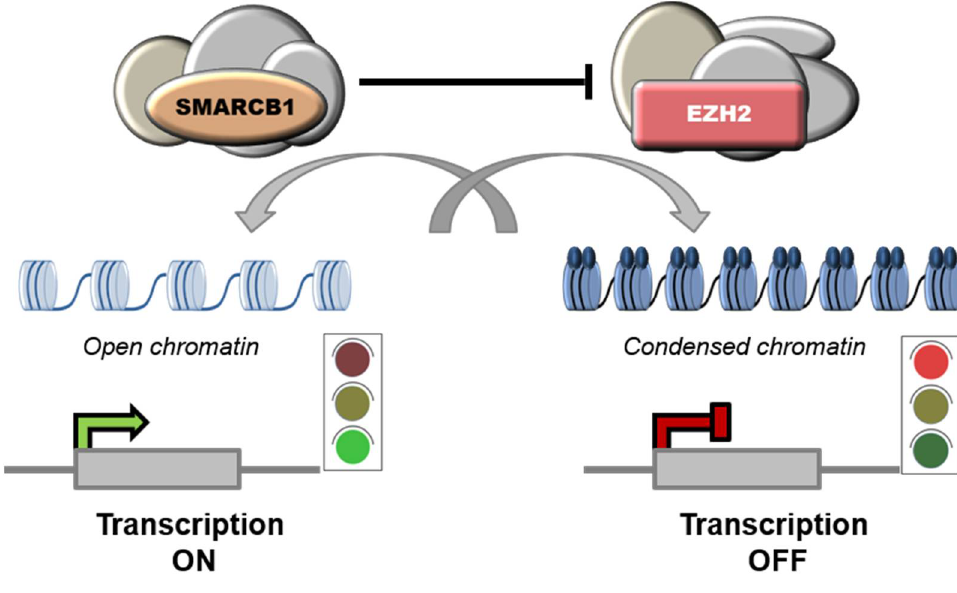
Figure 3. Functional antagonism between SWI/SNF and PRC2 complexes. SWI/SNF complexes reg- ulate nucleosome remodeling by promoting sliding or ejection of nucleosomes, thus facilitating gene expression. Instead, PRC2 complexes induce chromatin compaction and transcriptional repression by catalyzing methylation of histone H3 on lysine 27 (H3K27).